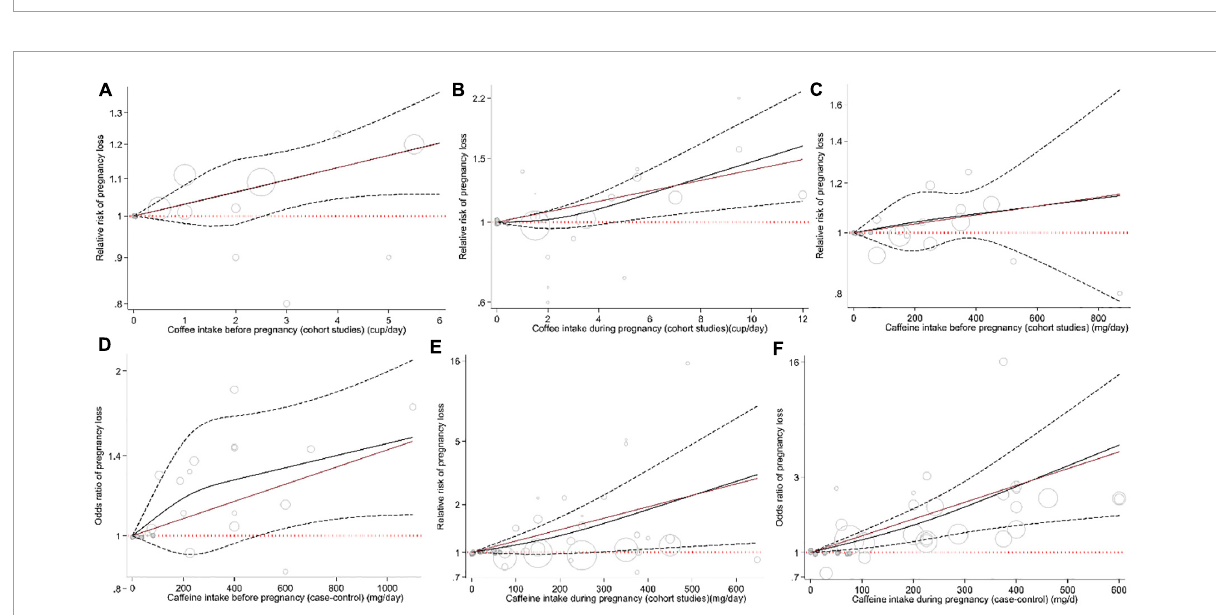
FIGURE4 Non-linear dose–response association between the risk of pregnancy loss and intake of coffee before pregnancy in cohort studies (A) , intake of coffee during pregnancy in cohort studies (B) , intake of caffeine before pregnancy in cohort studies (C) , intake of caffeine before pregnancy in case-control studies (D) , intake of caffeine during pregnancy in cohort studies (E) , and intake of caffeine during pregnancy in case-control studies (F)